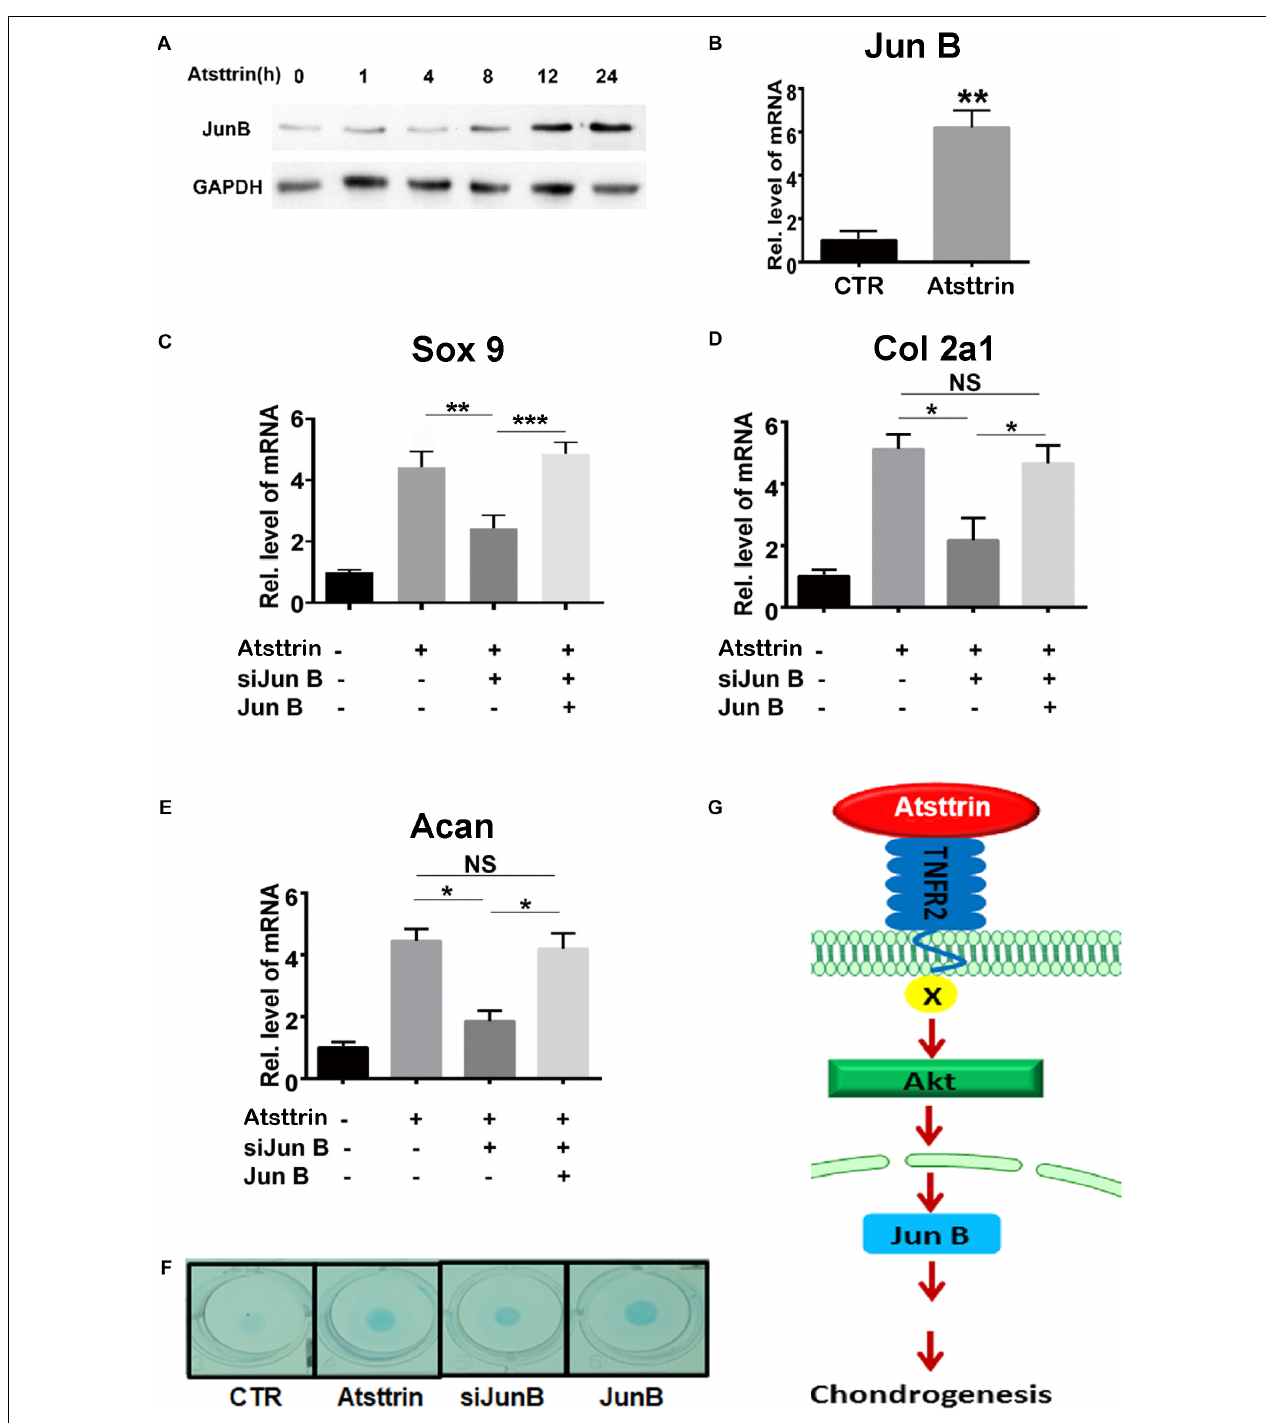
FIGURE 5 | Jun B was a downstream molecule of Atsttrin-mediated chondrogenesis. (A) Protein expression of Jun B in the presence of Atsttrin. C3H10T1/2 cells were micromass cultured with 1000 ng/mL Atsttrin for various time points, followed by Western blot analysis. (B) Transcriptional level of Jun B in C3H10T1/2 cells. C3H10T1/2 cells were micromass cultured in the absence or presence of 1000 ng/mL Atsttrin for 6 h, followed by real-time PCR. (C–E) Expression of Sox9, collagen II (Col2a1), and aggrecan (Acan) in C3H10T1/2 cells, which were micromass cultured in the absence or presence of 1000 ng/mL Atsttrin with or without transfection. C3H10T1/2 cells were transfected with pSuper JunB encoding an siRNA interfering with JunB expression, or a plasmid expressing JunB, or each plasmid in combination. Values were normalized to controls, here given the value of 1. Three independent experiments were performed. * P < 0.05. (F) C3H10T1/2 cells were incubated in the absence (CTR) or presence of 1000 ng/mL Atsttrin with transfected SiJunB or JunB for 10 days, followed by Alcian blue staining. (G) A proposed model for the role of Atsttrin in chondrogenesis.